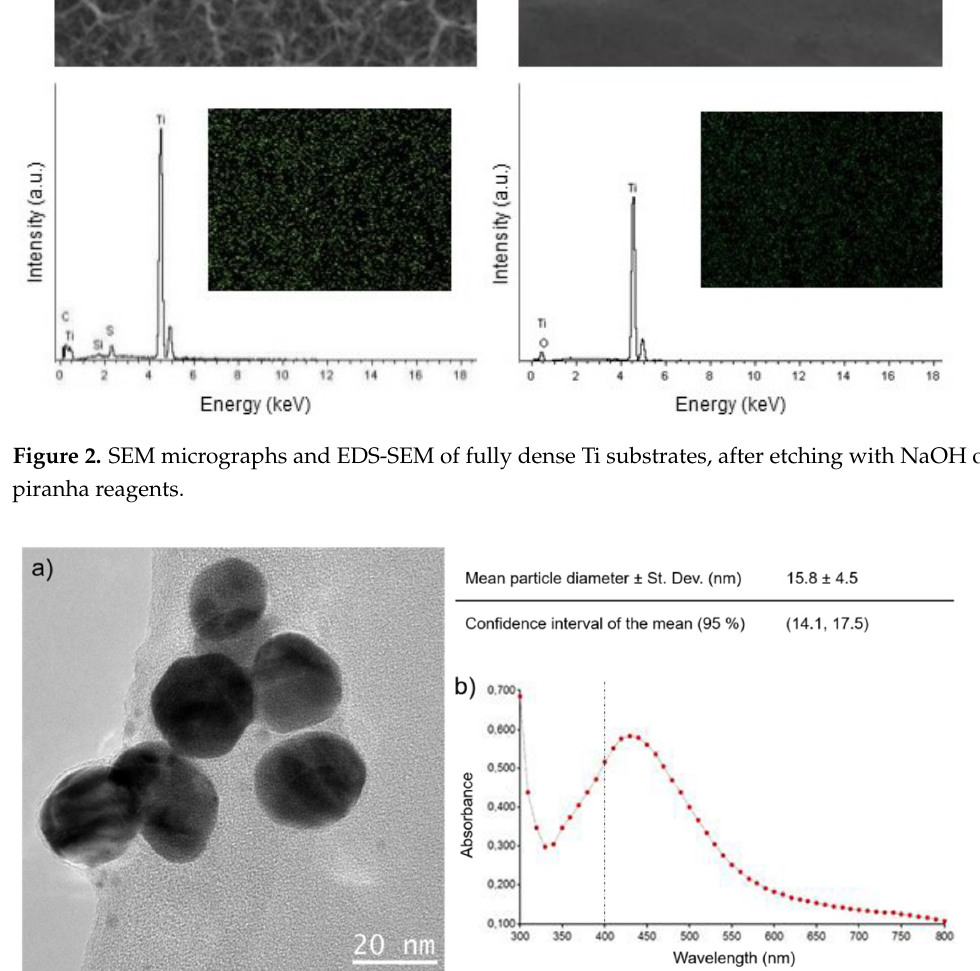
Table 3. Chemical reduction parameters of AgNPs at 25 °C.